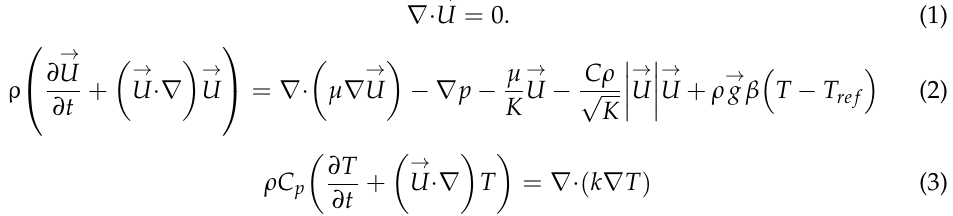
Table 2. Experimental process parameters of LSMW on the ANSI 304 stainless steel sheet.